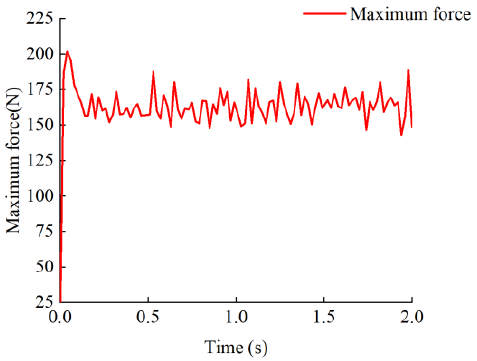
Figure 8. Variation of force on serrated disc with time.